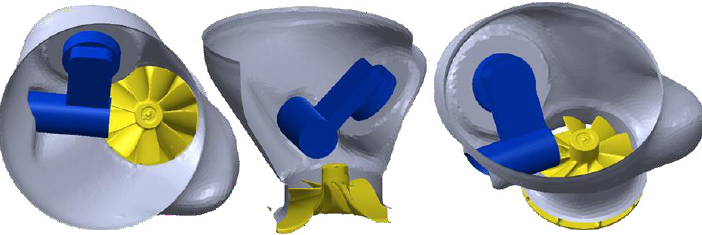
Figure 47. Stator blades’ von Mises stress distribution (top) and displacement (bottom) scenes.